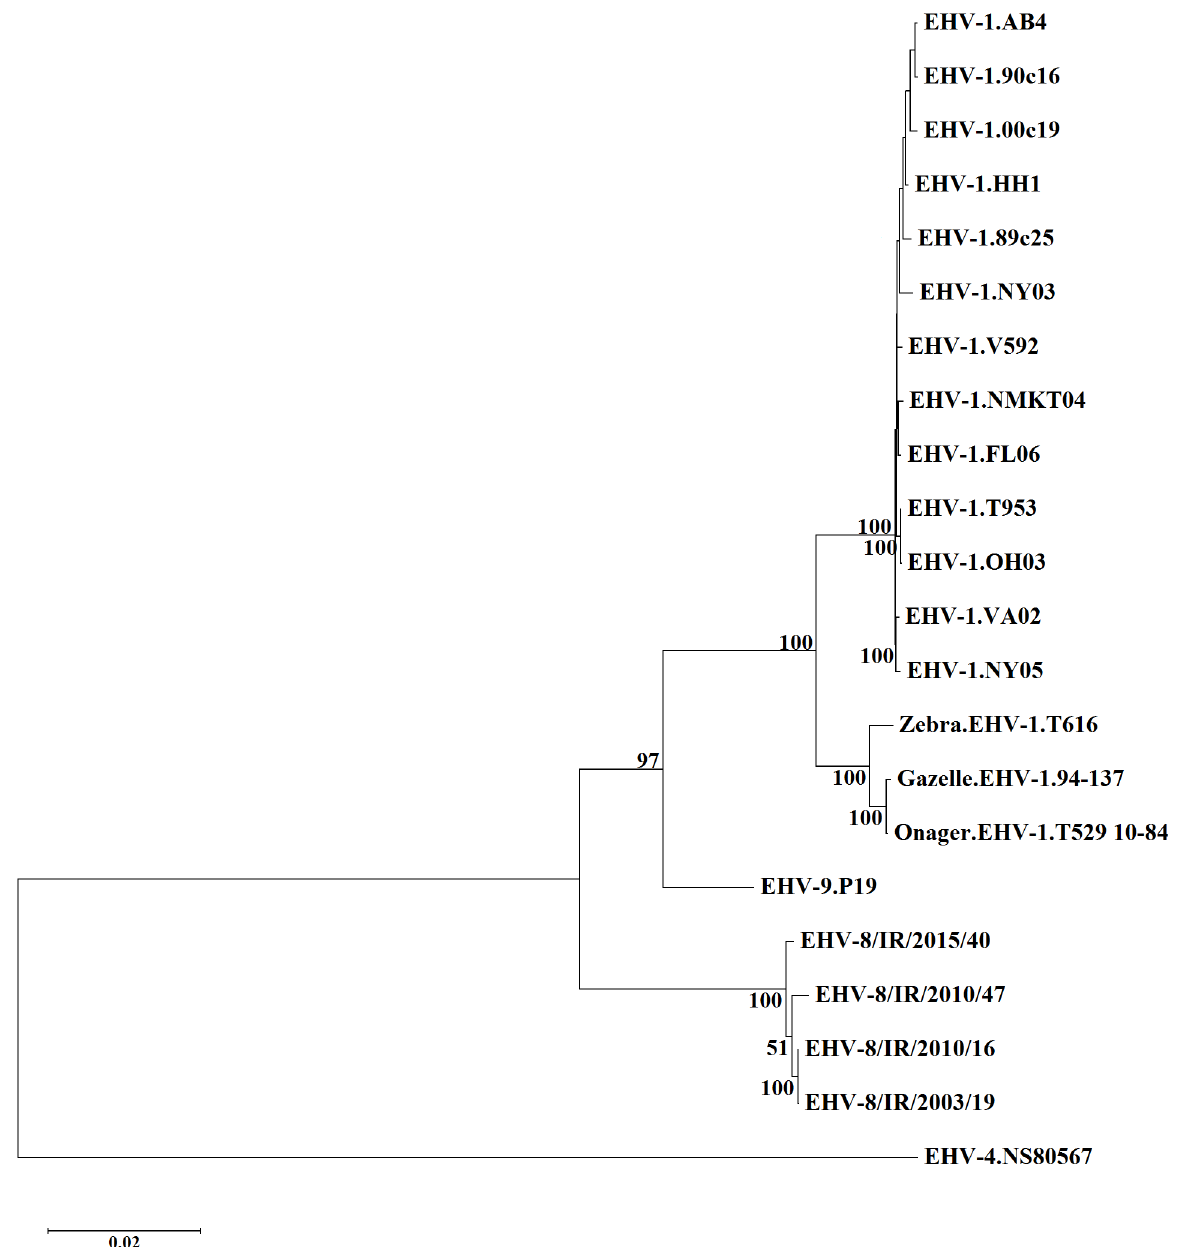
Fig 4. Phylogenetic tree of concatenated amino acid sequences of ORF3-ORF76 from the Irish equid herpesvirus 8 (EHV-8) strains, EHV-8 strain Wh and other equid alphaherpesvirus strains. The tree was constructed by using the maximum likelihood method based on the JTT matrix-based model [30], and is drawn to scale. Bootstrap values from 1000 replicates are shown as percentages at major nodes.